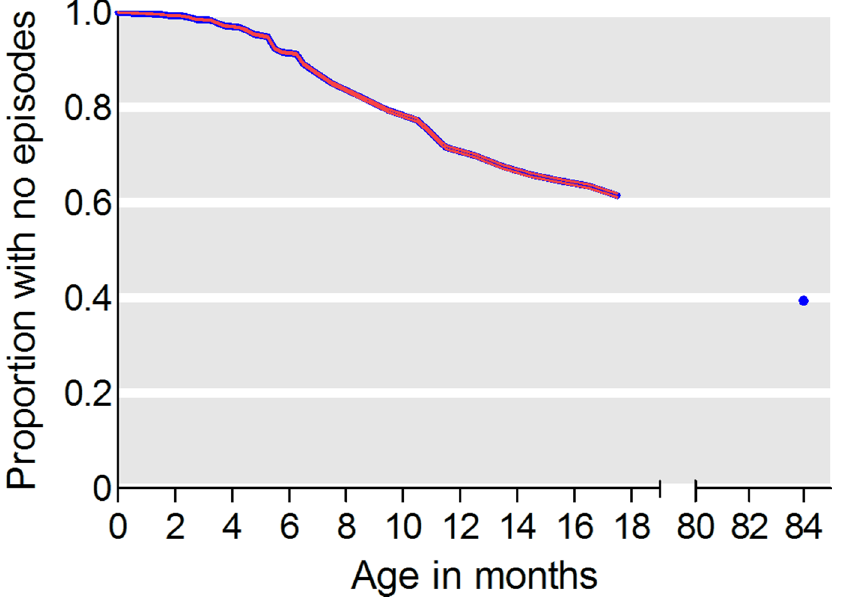
Fig. 1. Cumulative incidence of OM 0–7 years of age. Kaplan Meier survival curve with 95% confidence intervals (red line and dot) showing the cumulative incidence of otitis media (OM) in 81,374 children aged 0 months–7 years of age.